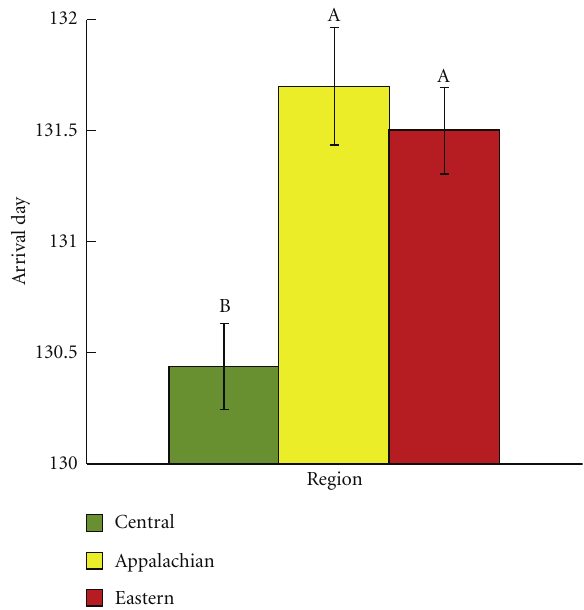
Figure 2: Di ff erence in mean first arrival dates ( ± S.E.) of Ruby- throated Hummingbirds in the Central ( N = 2002), Appalachian ( N = 1075), and Eastern Regions ( N = 1988; see Figure 1 for region designations). Arrival days are expressed in “day of year” and corrected for leap years; for example, “130” corresponds to May 10. Inset letters represent di ff erences that are significant at the P < 0 . 05 level.